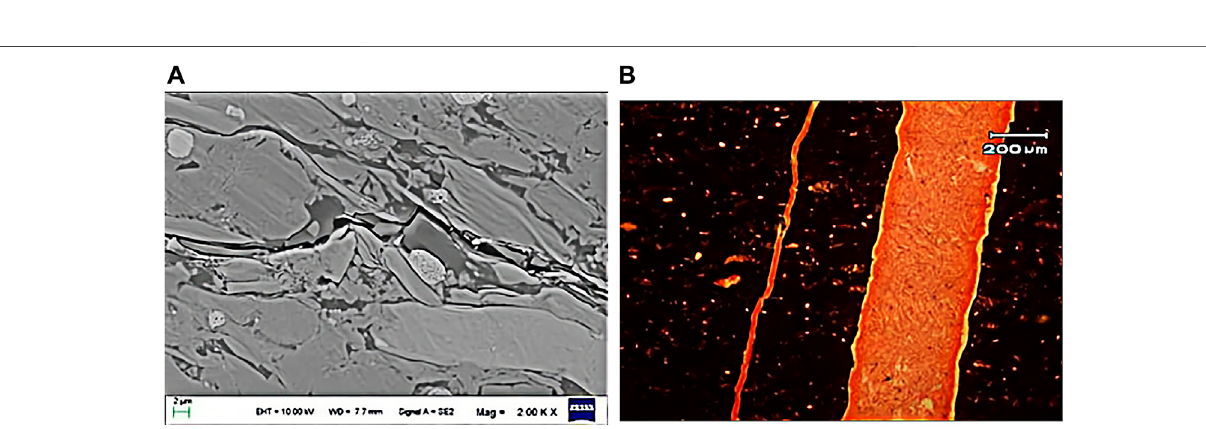
Frontiers in Earth Science |